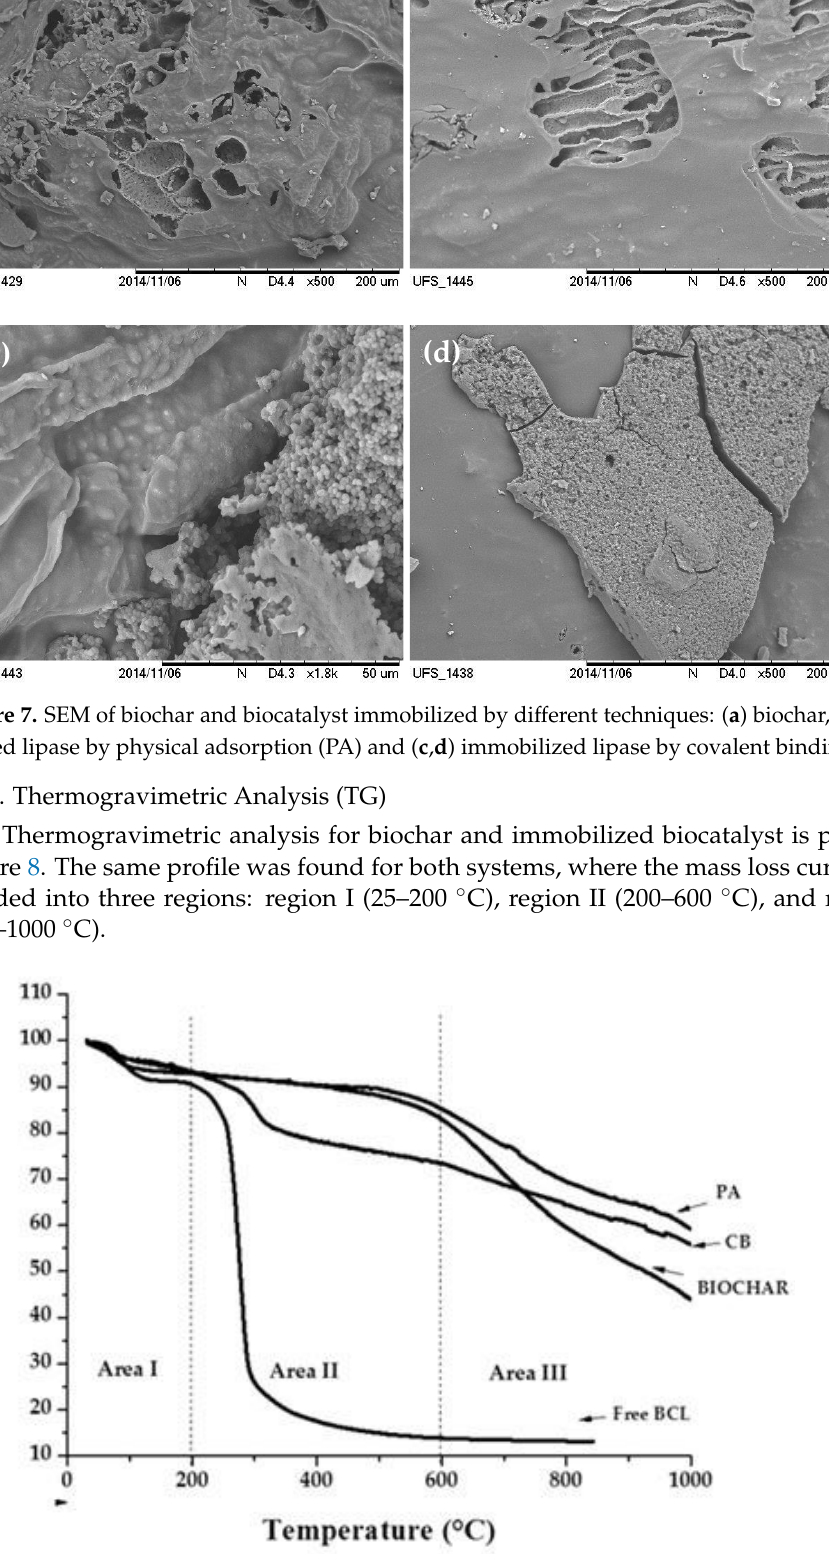
Figure 8. Thermogravimetric curves of the lipase of free BCL, biochar and biocatalysts immobilized by PA and CB. Table 3. Mass loss data (%) by TGA for the free lipase and immobilized biocatalysts.